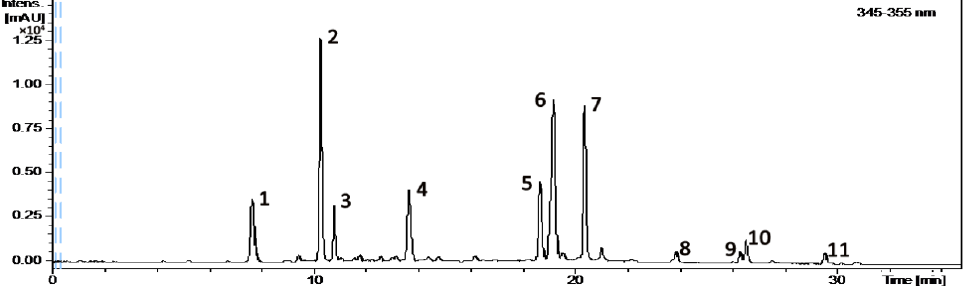
Figure 1. The HPLC chromatogram at 350 nm of ALE.